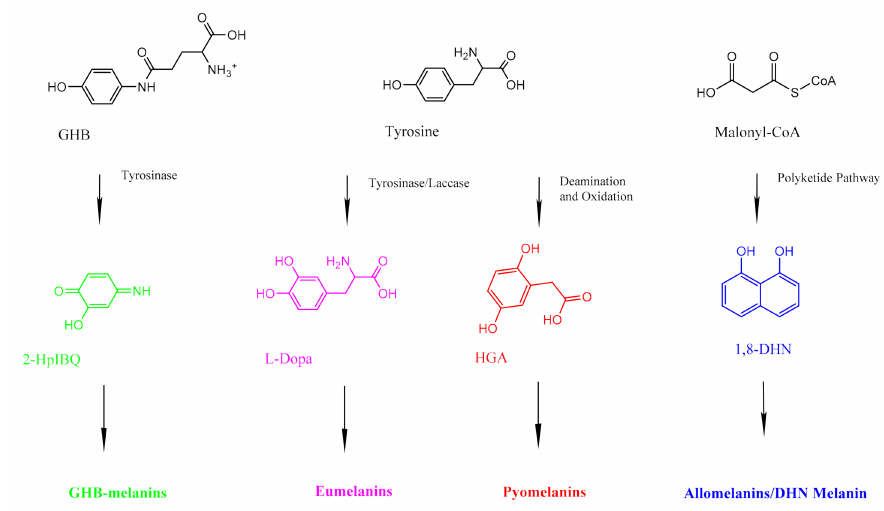
Figure 2. A simplified diagram showing the precursors for the three different kinds of fungal melanin. GHB-melanins (far left, green) are synthesized through a series of reactions with tyrosinase. Eumelanins (center left, pink) are synthesized via the L-Dopa pathway, which uses tyrosine as a precursor. Pyomelanins (center right, red) also use tyrosine as a precursor but are ultimately derived from HGA. Allomelanins (far right, blue) are derived from